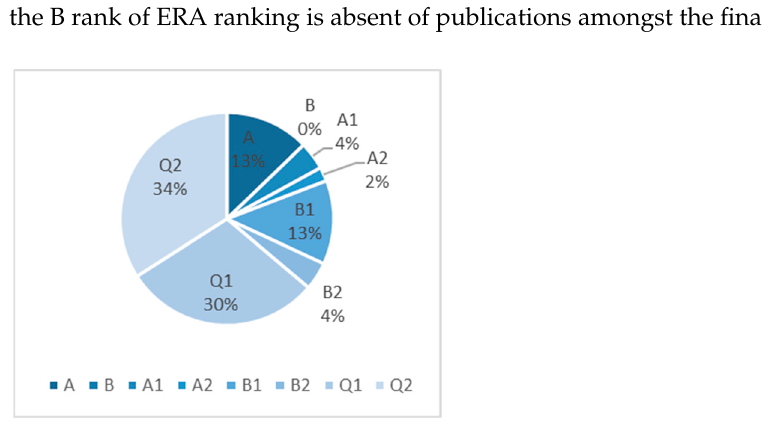
Figure 2. Flow of the Filtration Process.